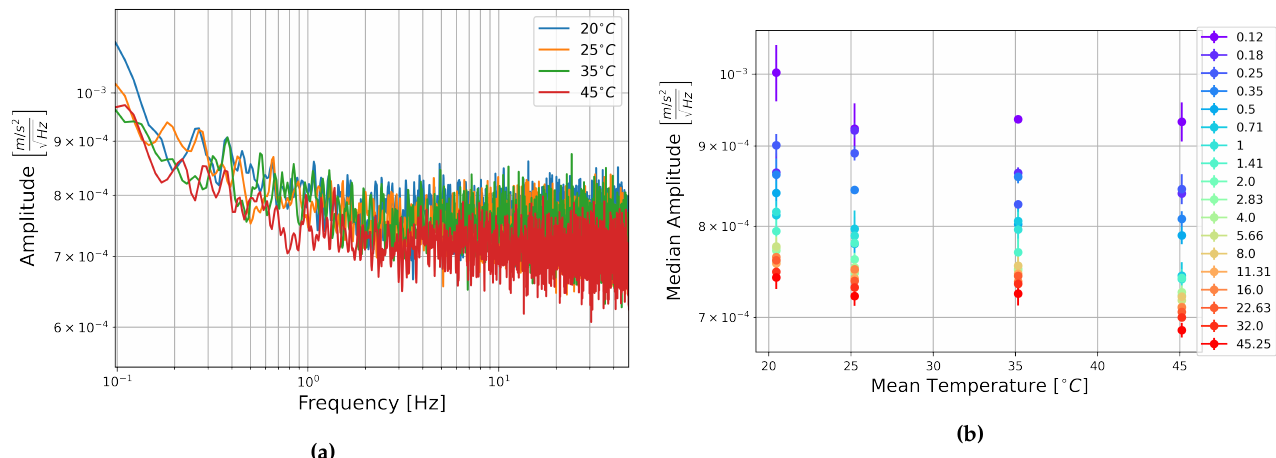
Figure 13. ( a ) Square root of the PSD of component HNX at each temperature step and ( b ) Median amplitude of the PSD per half-octave as a function of temperature. Vertical error bars show standard deviation of amplitudes, and horizontal bars show standard deviation of temperature measurements.